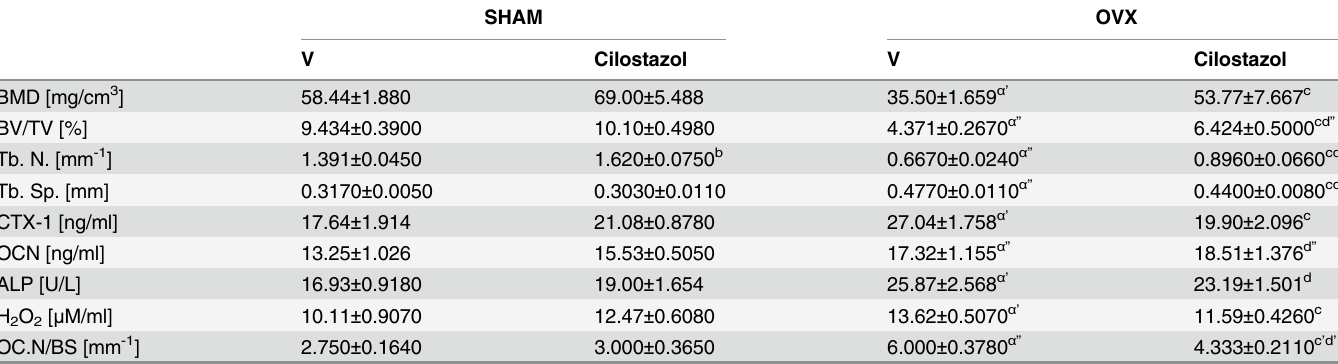
Table 1. Trabecular microarchitecture and biochemical markers of OVX and SHAM mice treated with cilostazol at 8-weeks after surgery.